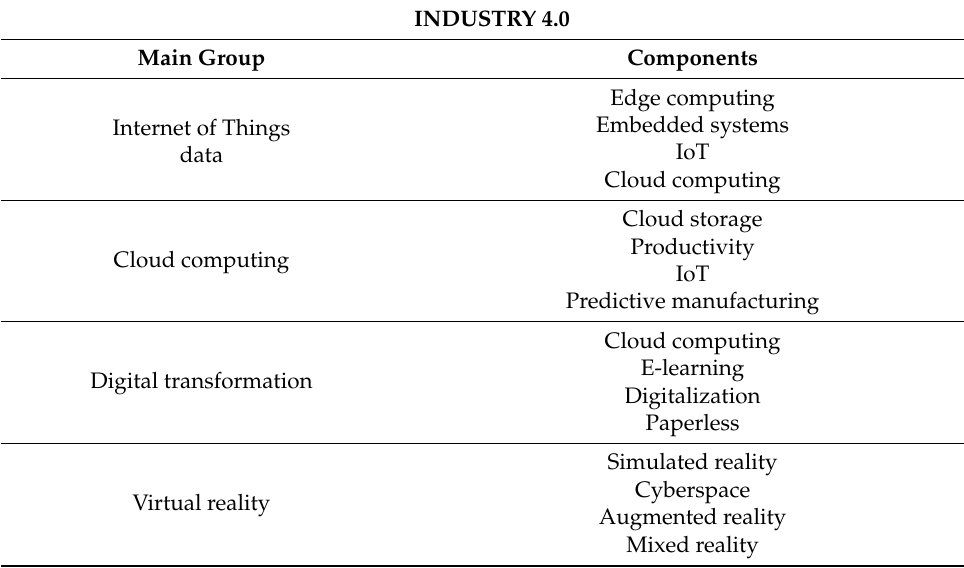
Table 1. Industry 4.0 Technologies (own work, based on